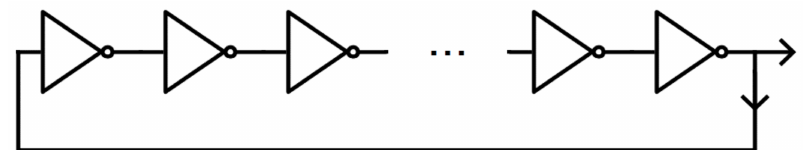
Figure 1. Diagram of a ring oscillator created by closing a chain of